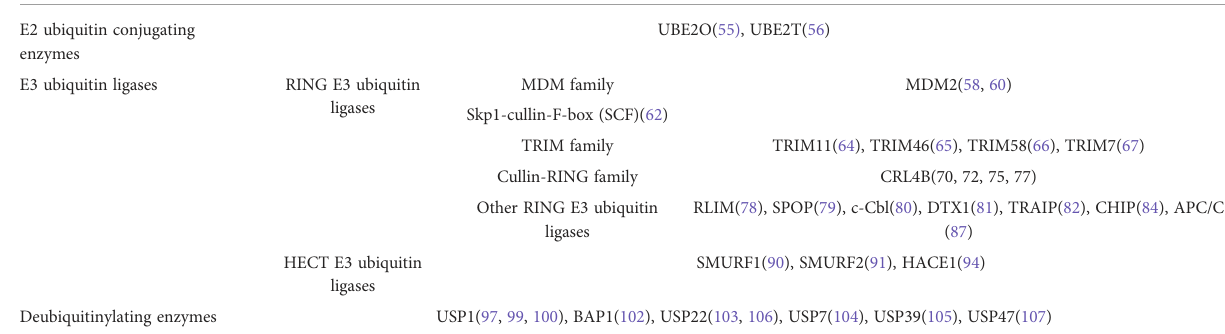
TABLE 3 Osteosarcoma related ubiquitin enzymes and deubiquitinylating enzymes.